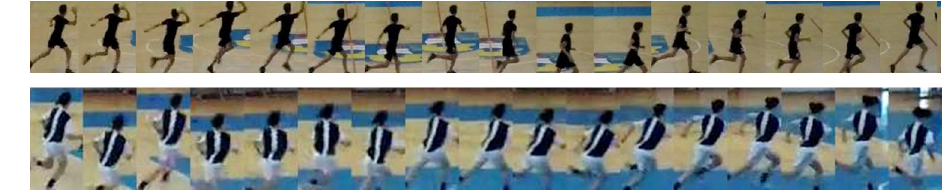
Figure 18. Examples of imprecise player detection.